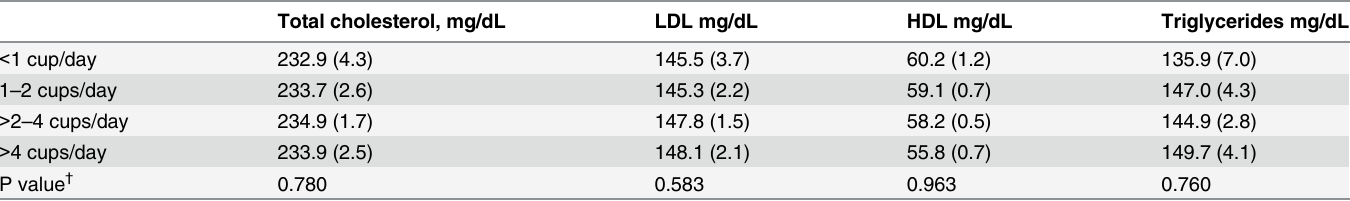
Table 3. Multivariable-adjusted means * (standard error in parentheses) of triglycerides and total, LDL and HDL cholesterol, by categories of cof- fee consumption, in 1472 randomly selected EPICOR